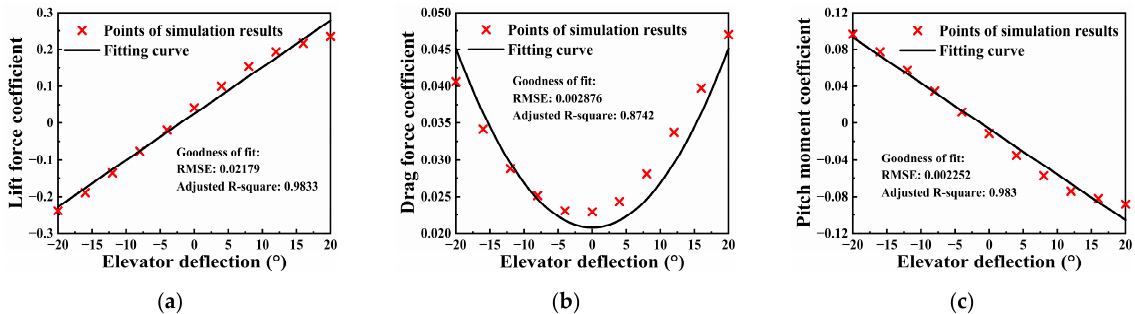
Figure 4. Curve fitting of aerodynamic coefficients versus the elevator deflection: ( a ) lift force; ( b ) drag force; ( c ) pitch moment.